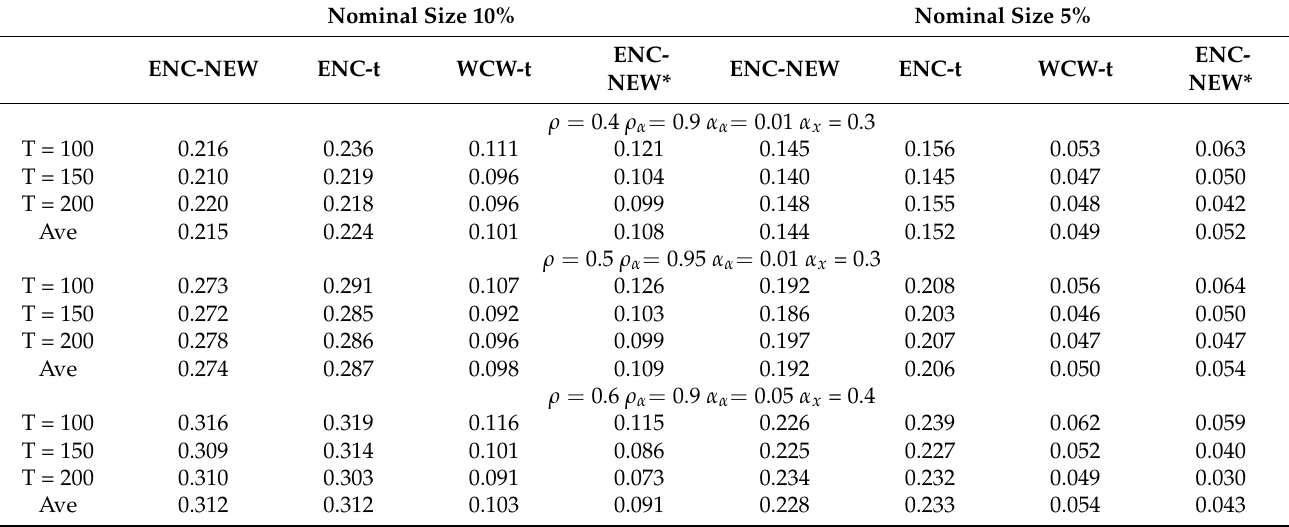
Table 7. Empirical Size for P/R =